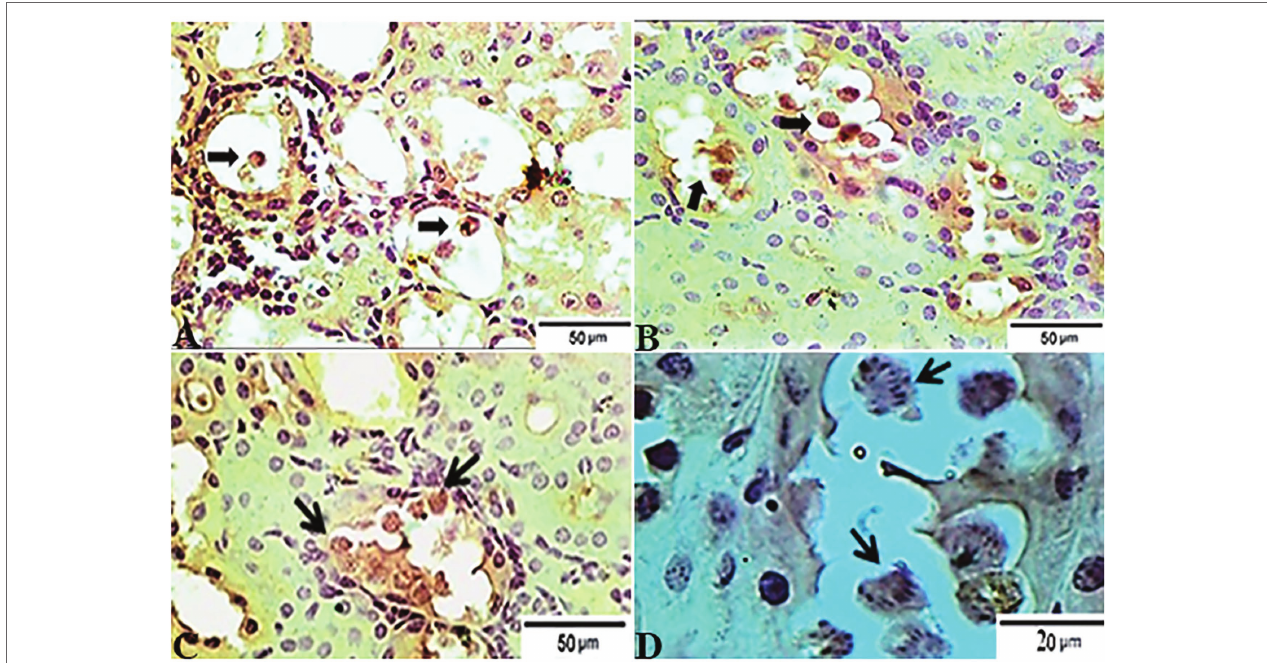
FIGURE 7 | Photomicrograph of immunohistochemical staining for anti- Toxoplasma gondii anti IgG in kidney sections from experimental mice groups showed positive golden brown immunoreactive T. gondii tissue cysts fill most of the infected renal tubules using IHC technique, DAB stain; (A) control positive group infected with ME49 Avirulent strain of T. gondii showing mild tissue IHC reaction. (B) Treated group for 14 days showed moderate IHC tissue reaction. ( C magnified in D ): from the treated group for 28 days; strong positive results by IHC represented by the presence of multiple golden-brown positive immunoreactivity T. gondii tissue cysts nearly occludes the infected renal tubules. The bar size of each picture was indicated under each picture.